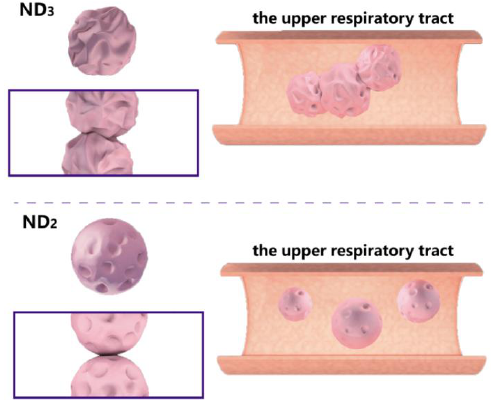
Figure 8. The influence of a corrugated particle surface in the respiratory tract.